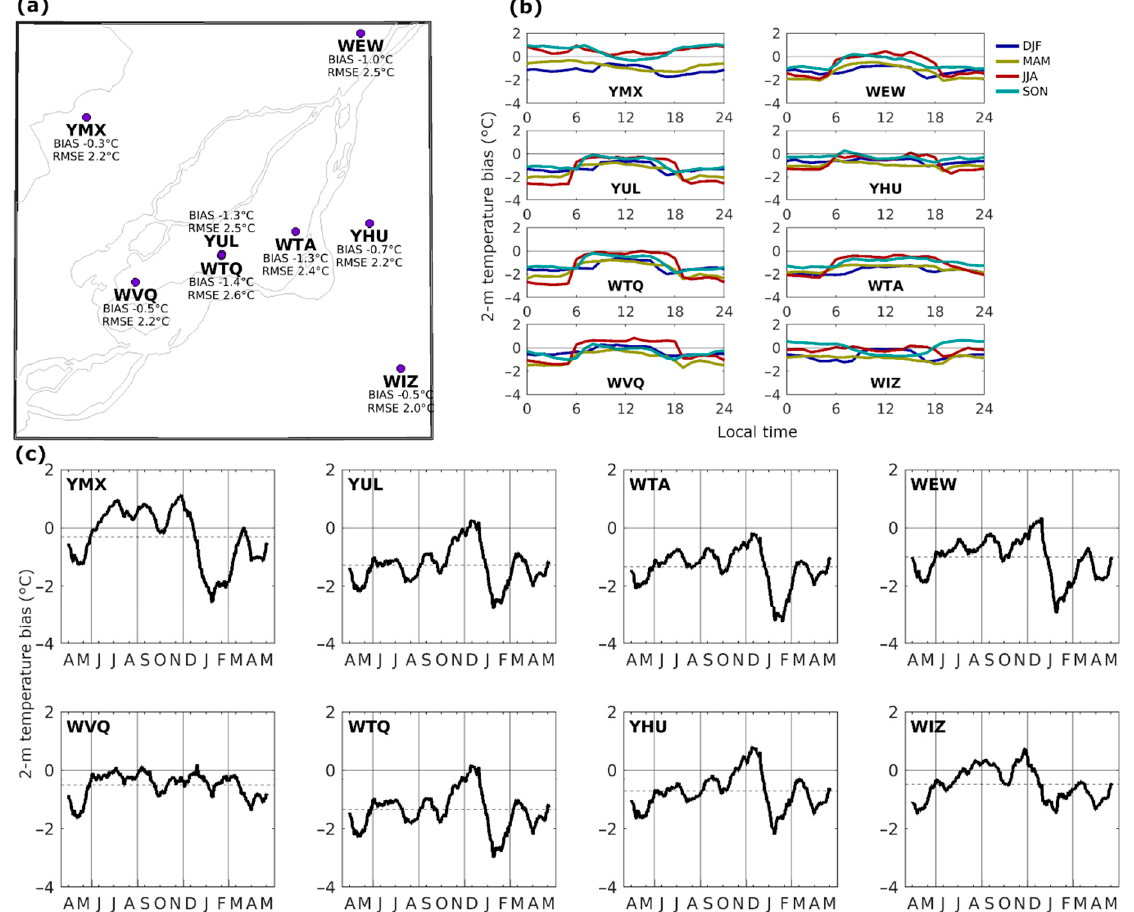
Figure 4. ( a ) Location of the 2 m temperature observation stations in the study domain. Station code, average bias, and root mean square error (RMSE) are shown for each station. ( b ) Daily cycle of the 2 m temperature bias for each season at each station. ( c ) Evolution of the 30-day moving average 2 m temperature bias at each station from April 2019 to May 2020. Dashed lines show the average bias during the entire period.